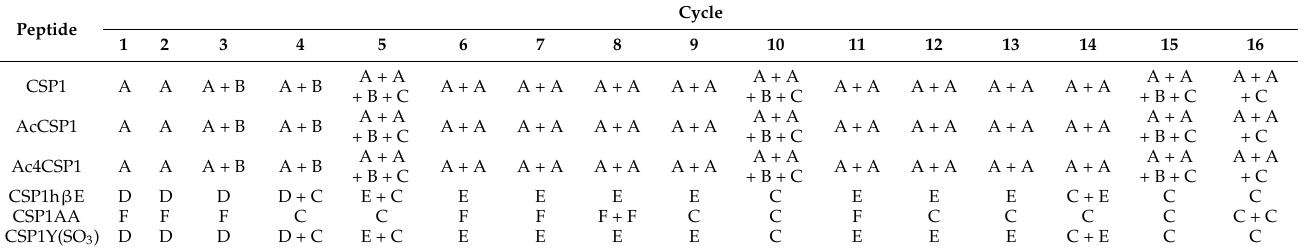
Table 2. Coupling conditions for each step of the peptide